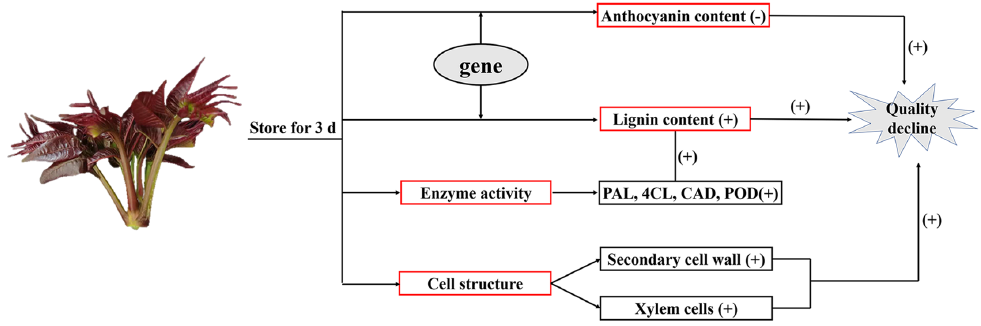
Figure 6. A model to elucidate the senescence mechanism involved in lignin and anthocyanin metabolism of red T. sinensis buds during storage. +: marks the promotion of senescence.